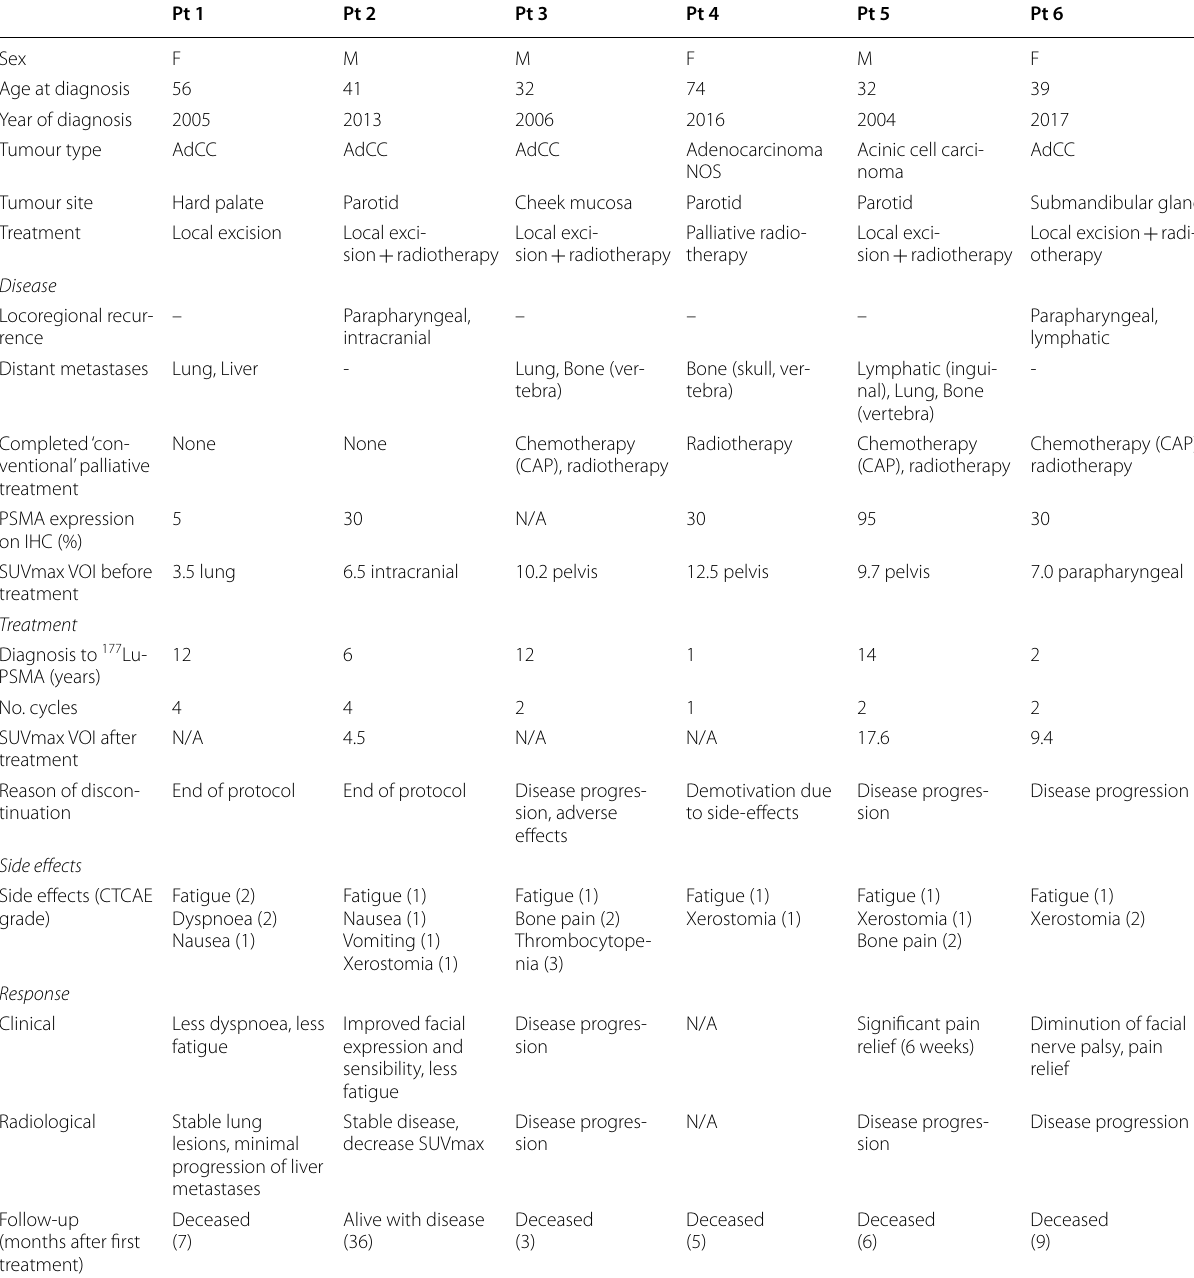
Table 1 Patient, disease and treatment characteristics